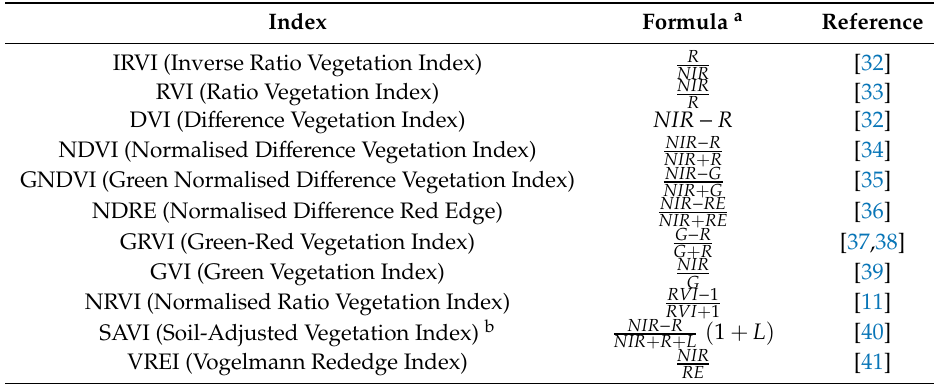
Table 1. Vegetation indices applied.